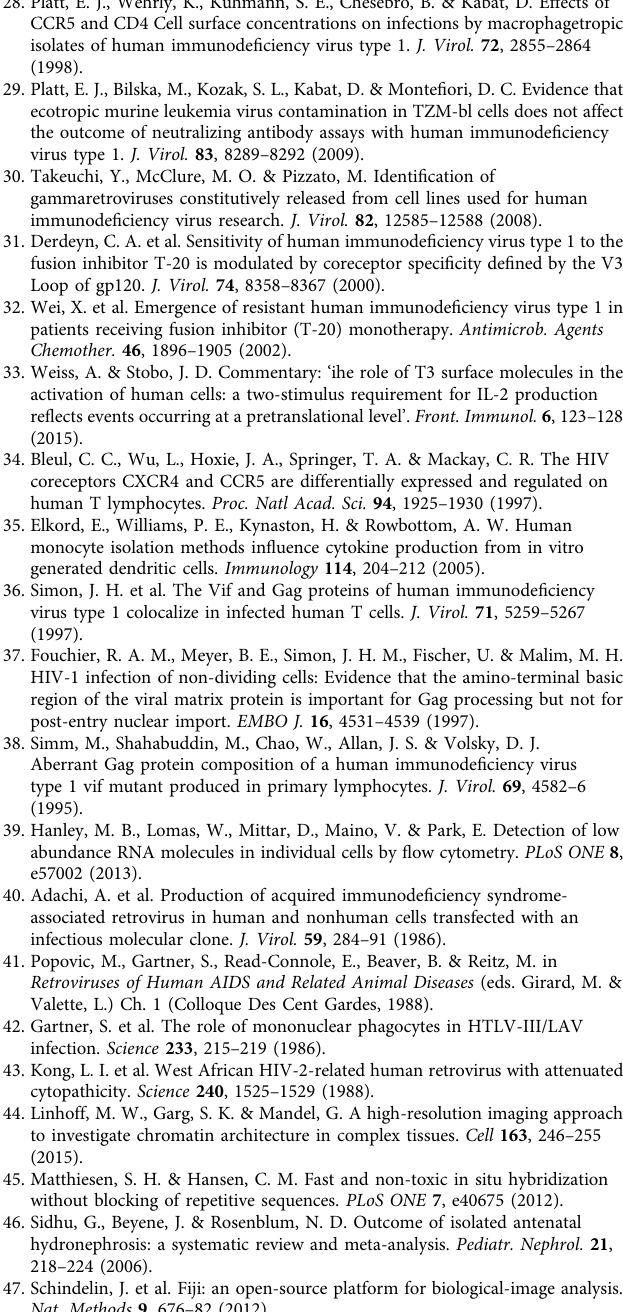
Data availability . All data supporting the fi ndings in this paper are included in the main text and Supplementary Information. All relevant data are available from the authors upon